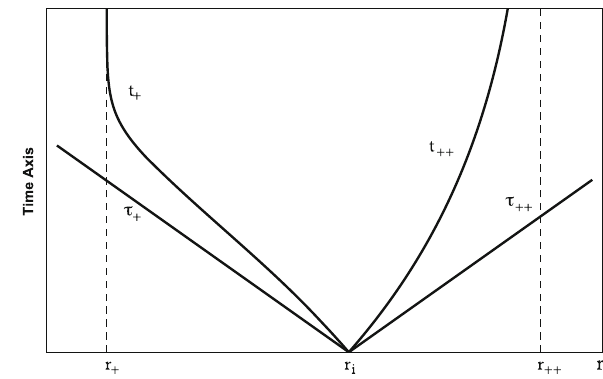
Fig. 2 Temporal behavior for radial null geodesics on the background of a charged Weyl black holes. In the proper system, photons can cross the horizons in a finite time [in accordance with Eq. (22)], whereas regarding Eq. (23), an observer at r i measures an infinite time for r → r + or r → r ++ . The same behavior is seen in the study of photon motion in static spherically symmetric spacetimes in the context of general